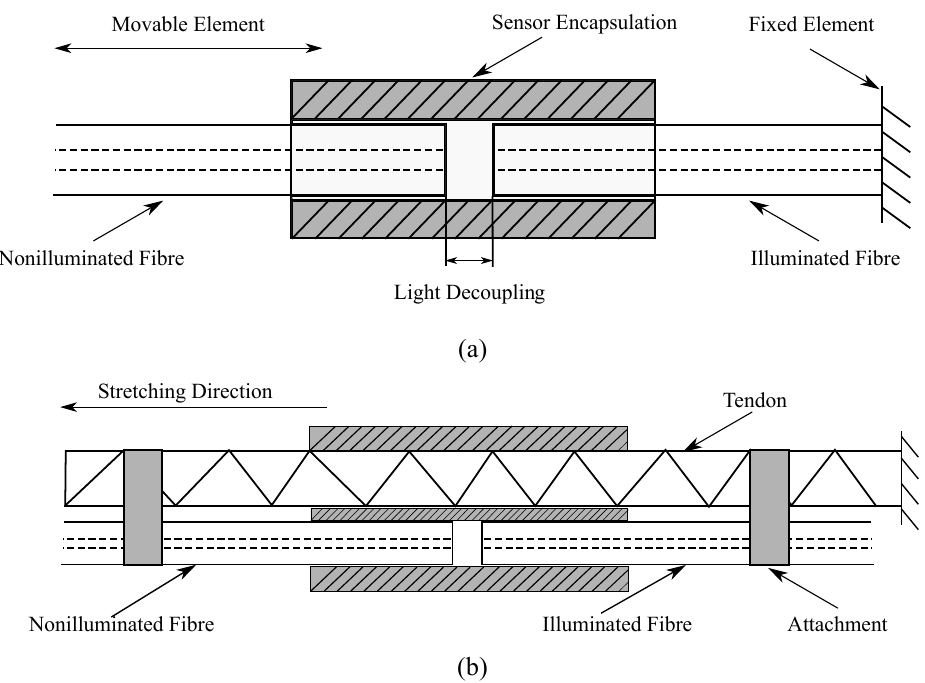
Figure 6. Experiment setup to validate sensor response. ( a ) Two fibers (illuminated and